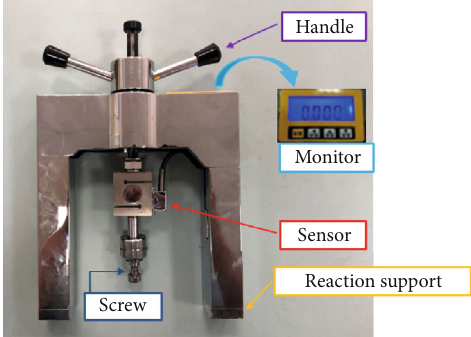
Figure 2: HCTC-10 coating adhesion tester.